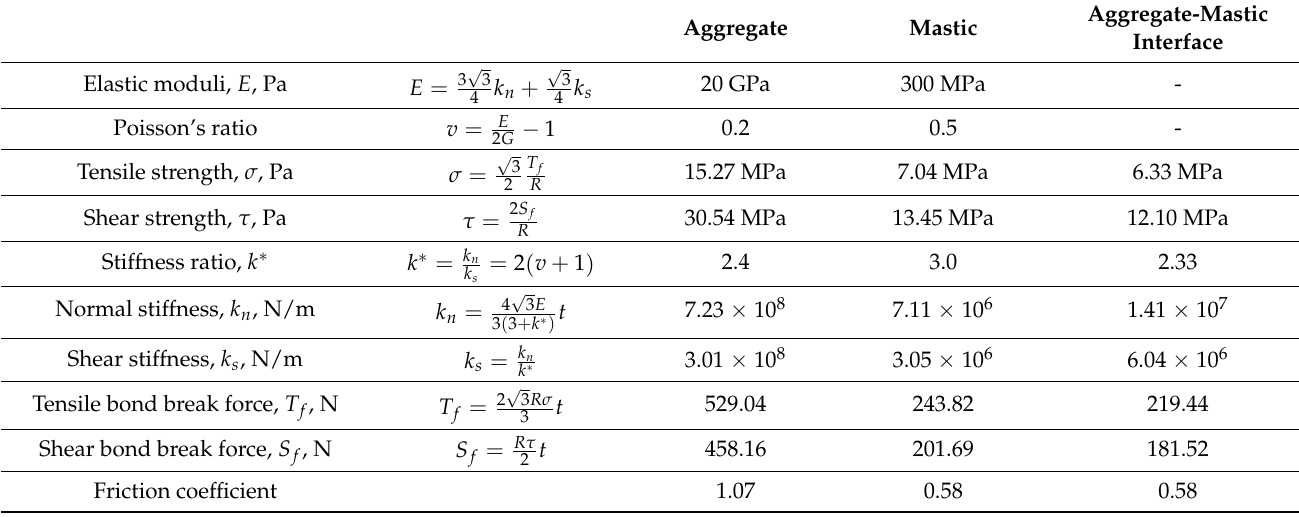
Table 2. Martial Properties and Micro-parameter.